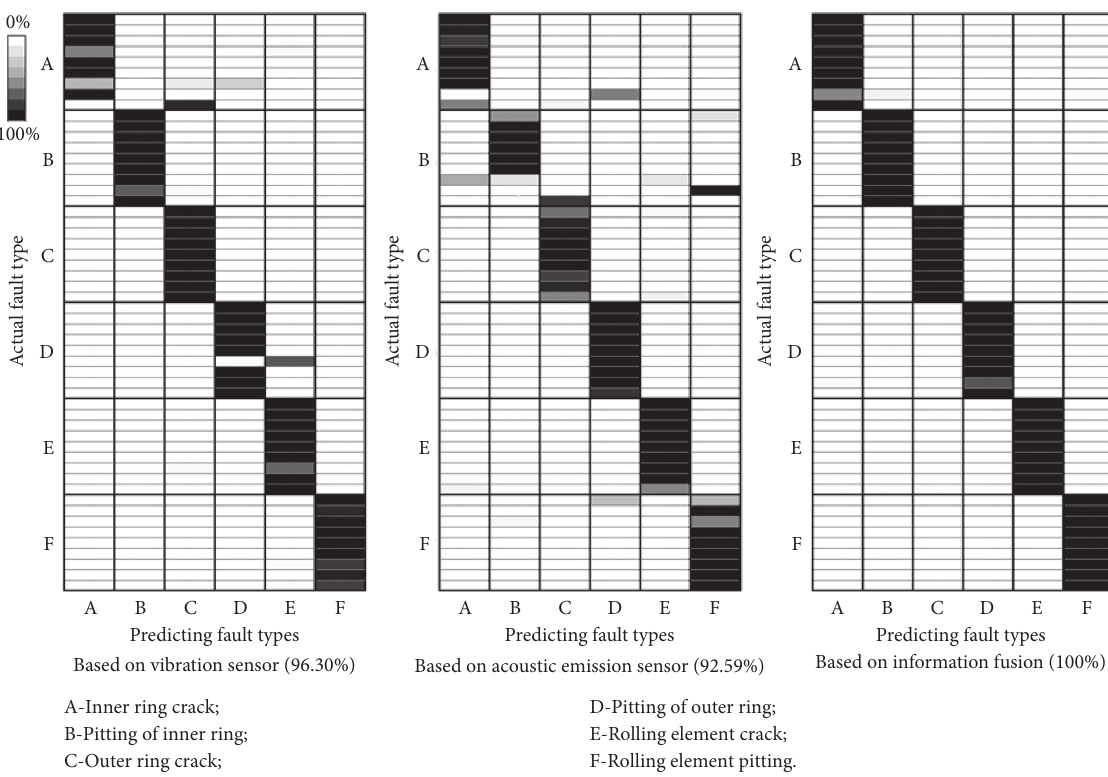
Figure 13: Accuracy rate of general condition fault